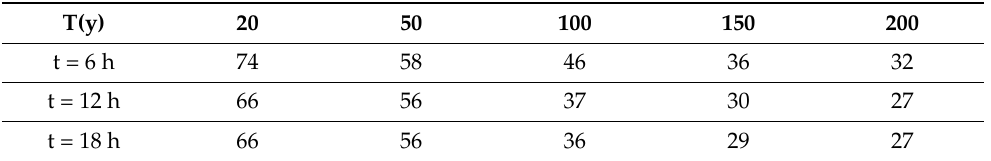
Figure 13. Flood risk in the residential area for 4 indicative scenarios: ( a ) Scenarios S20-06 ( left ) and W20-06 ( right ) for T = 20 y and t = 6 h. ( b ) Scenarios S200-18 ( left ) and W200-18 ( right ) for T = 200 y and t = 18 h. Table 9. Reduction in the risk (%) on Koropouli Street due to the presence of the flood protec- tion